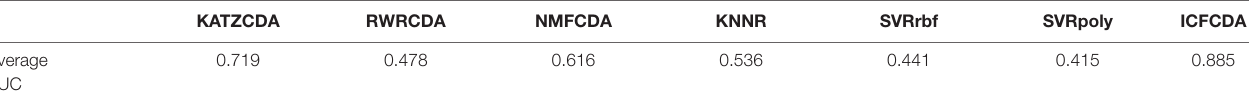
TABLE 1 | The average AUC values of 42